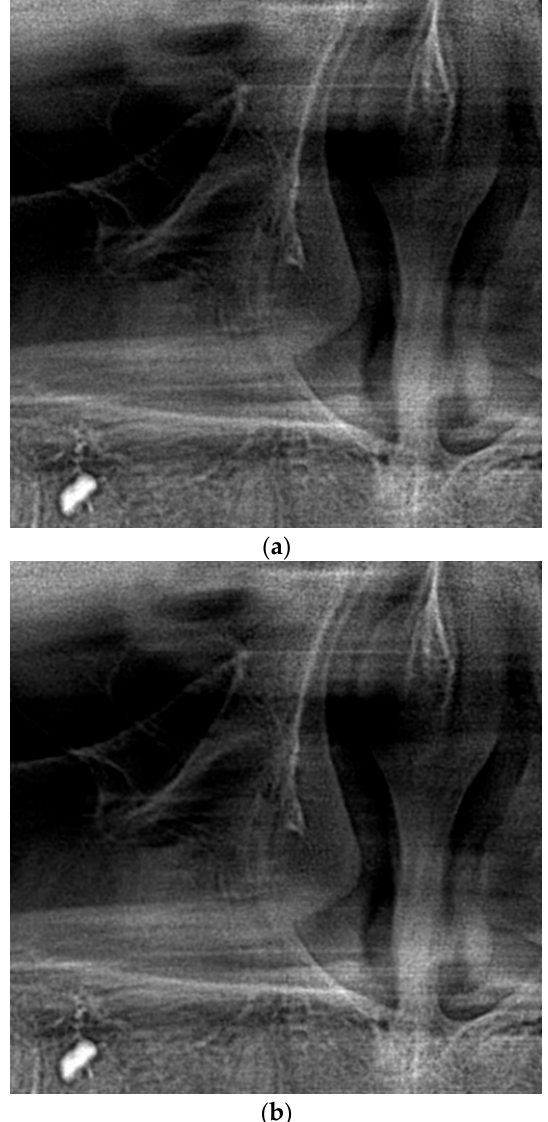
Figure 7. A fragment of dental image before ( a ) and after ( b ) compression with the recommended QS, CR = 13.5.